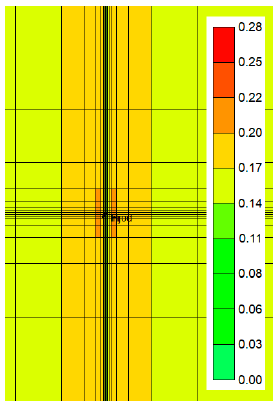
Figure 12. Cumulative condensate recovery with different injection pressure. Figure 12 . Cumulative condensate recovery with different injection pressure. Figure 12 . Cumulative condensate recovery with different injection pressure.